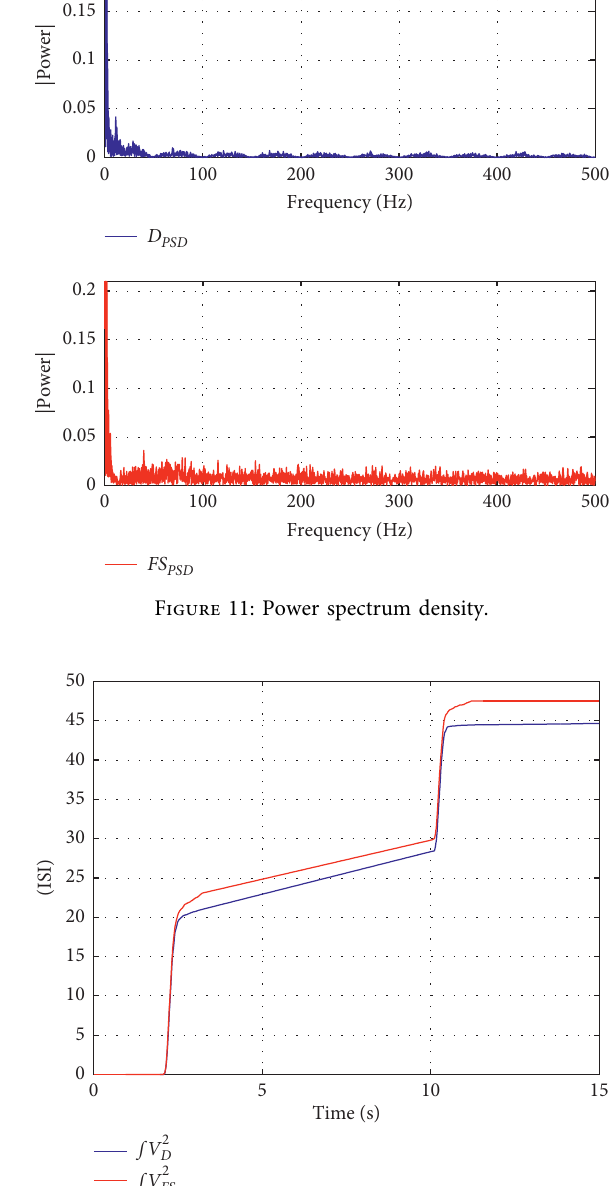
Figure 12: Performance index of the